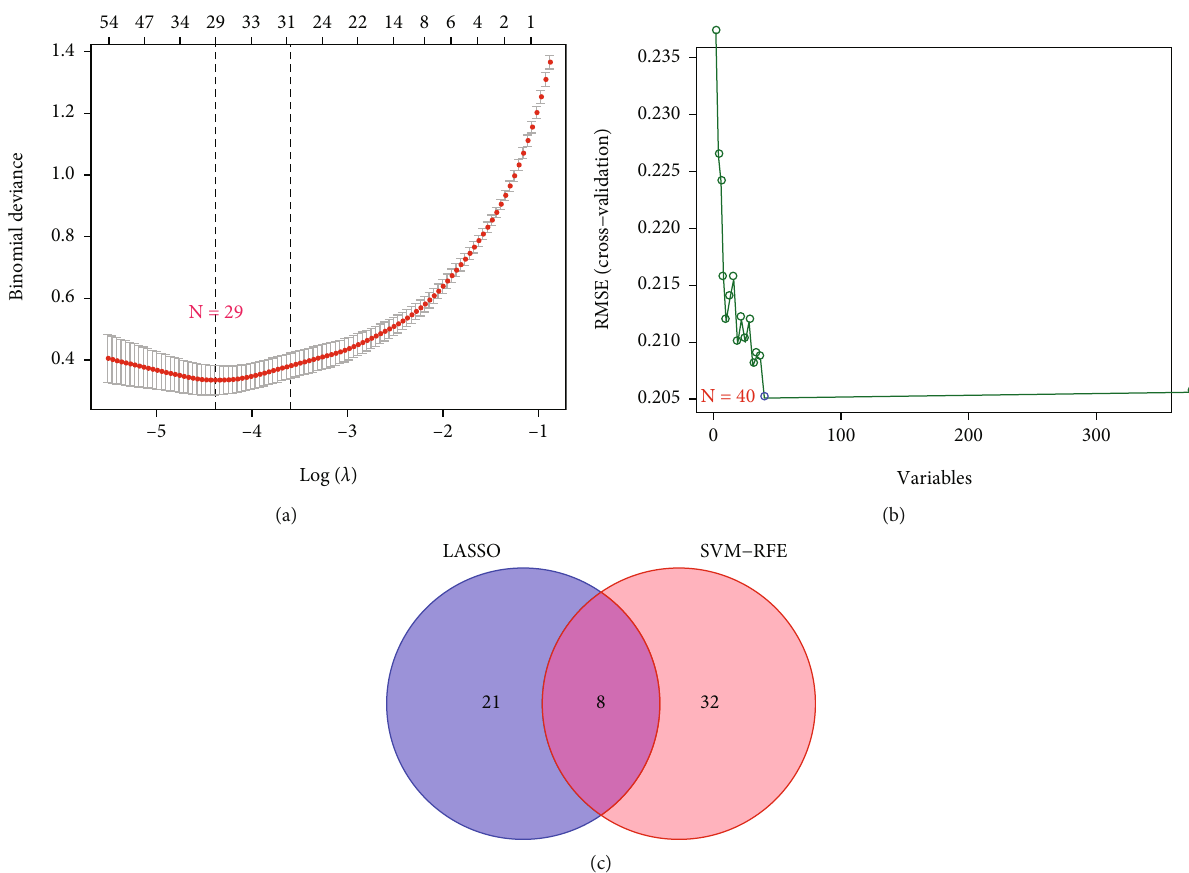
Figure 3: Screening for potential diagnostic gene biomarkers of HCC by two machine learning strategies. (a) Screening diagnostic gene biomarkers using the least absolute shrinkage and selection operator (LASSO). (b) The optimal gene biomarker selection via support vector machine-recursive feature elimination (SVM-RFE) algorithm. (c) Venn diagram displaying eight diagnostic biomarkers shared by LASSO and SVM-RFE